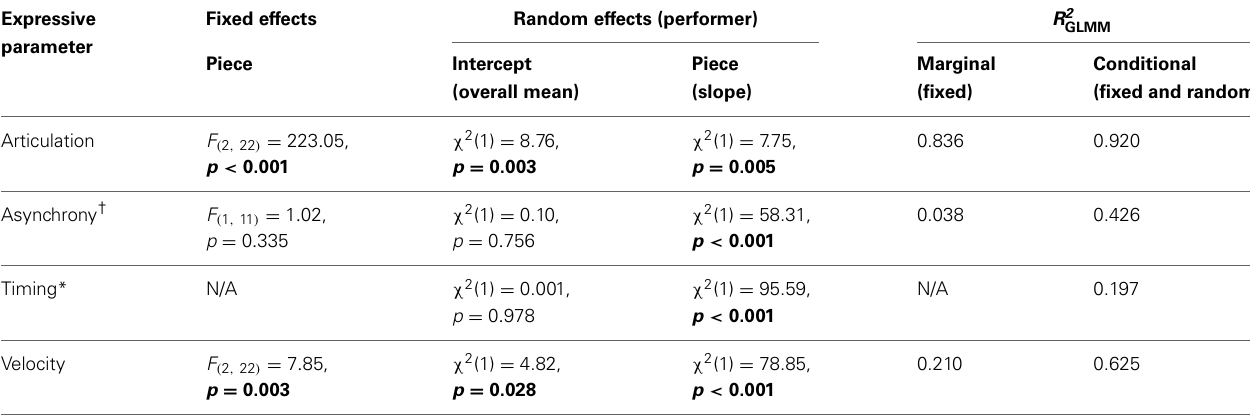
Table 1 | Linear mixed models comparing across recordings of the three